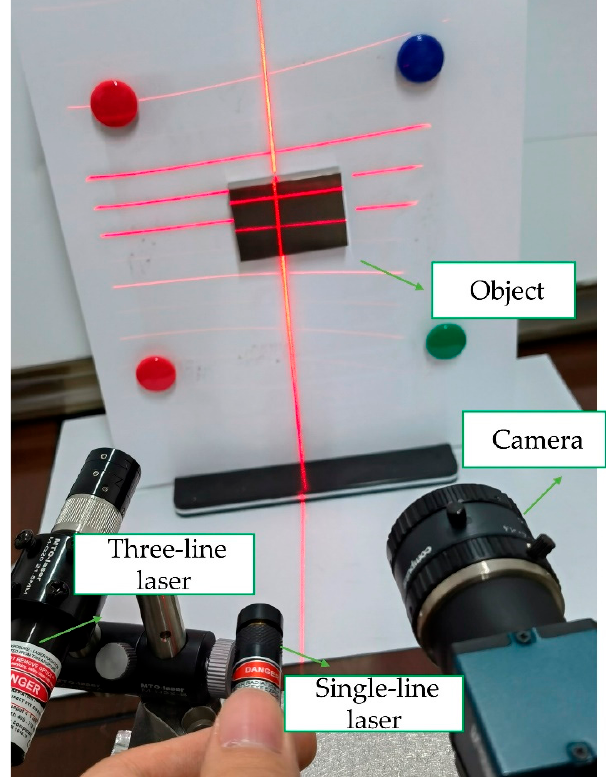
Figure 17. Measurement image of the standard gauge block.